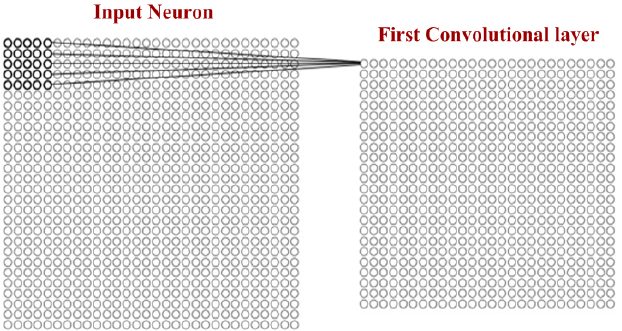
Figure 3. Visualization of filter of size 5 × 5 with activation map. (Input neuron 28 × 28 and convolutional layer 24 × 24).